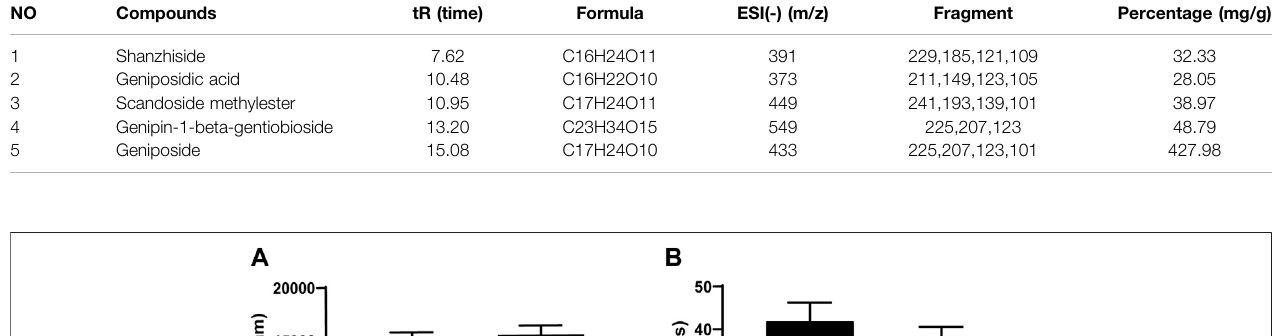
Frontiers in Pharmacology |